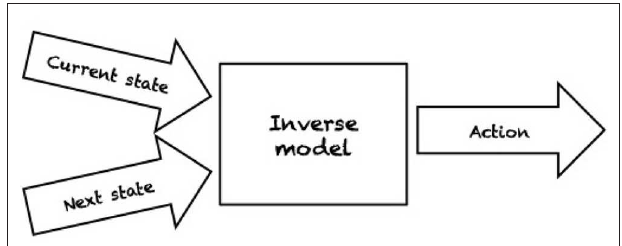
FIGURE 1 | An inverse model computes an action which will affect the environment such that the next desired state (or configuration) is achieved from the current state.